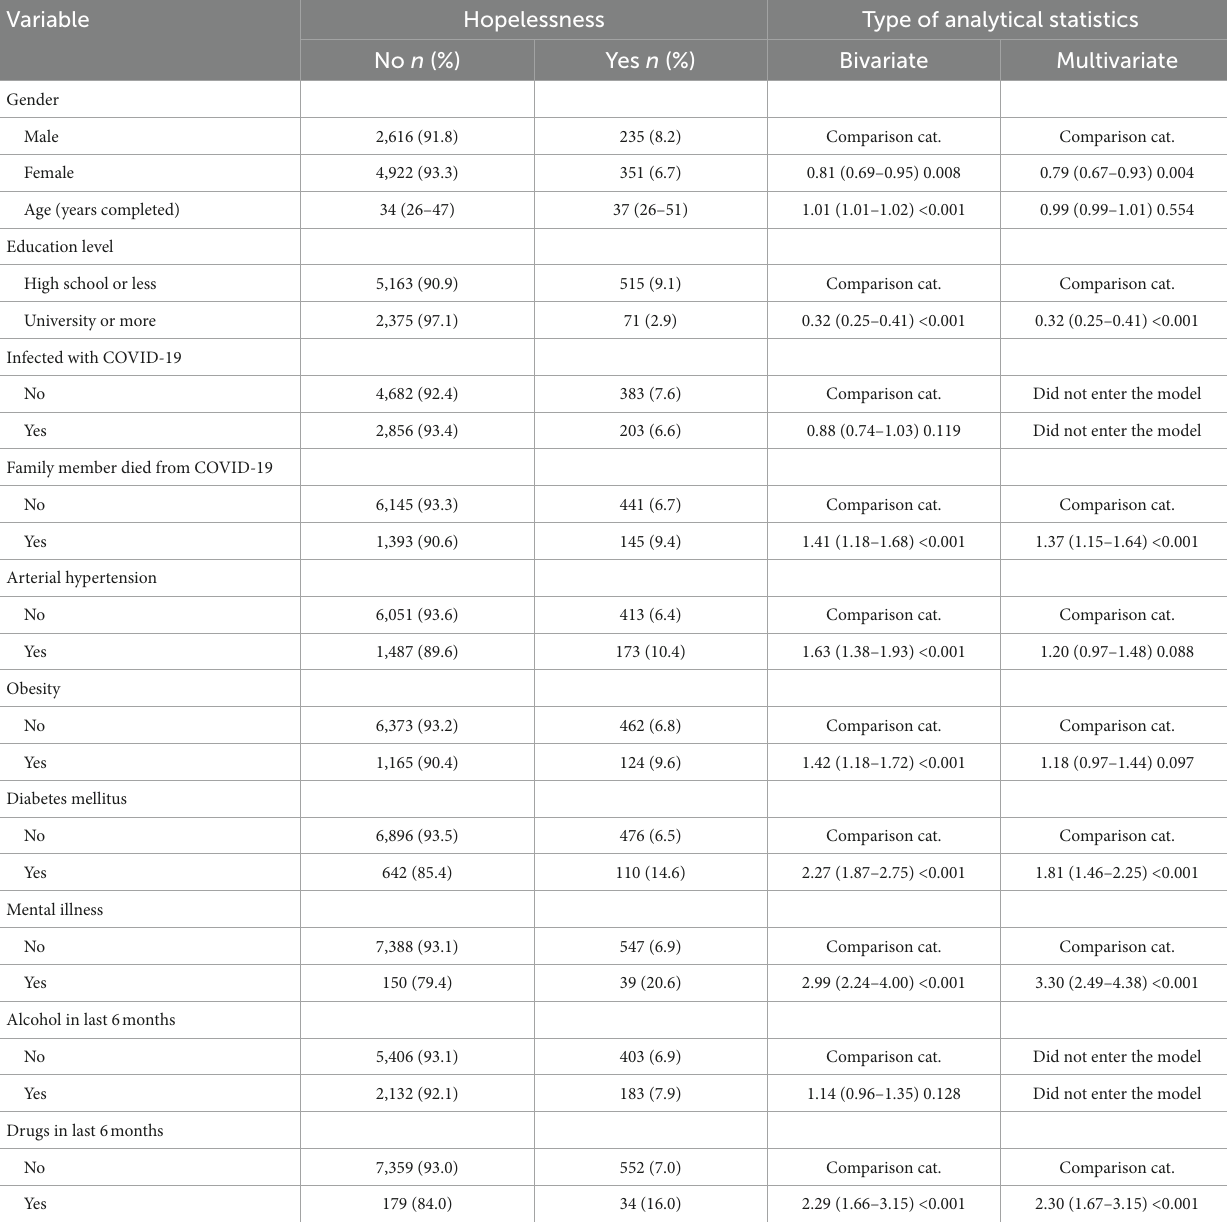
TABLE 2 Factors associated with hopelessness in Honduran residents in the COVID-19 pandemic, in the period 2021–2022, ( n =